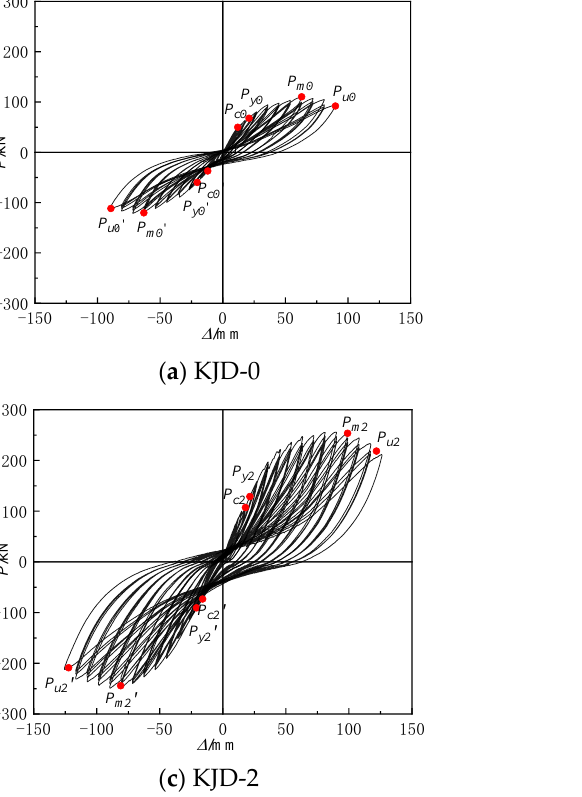
Figure 10. Skeleton curves of each specimen.